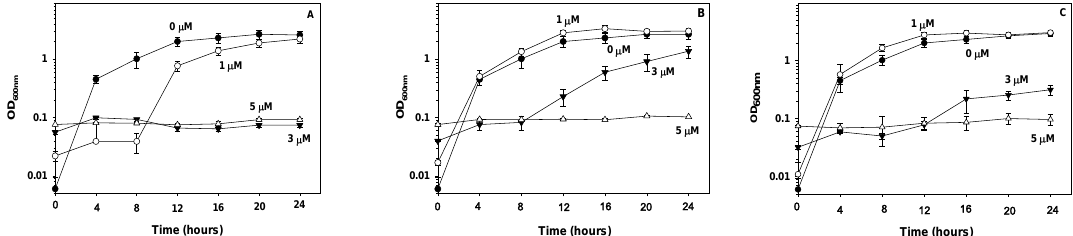
Figure 2. Concentration-dependence of the effect of FePs on E. coli proliferation. Overnight GC4468 LB cultures were diluted 200-fold in M9CA medium. One hundred-microliter aliquots were transferred to a 96-well plate and FePs were added to the specified final concentrations. ( A ) FeTE-2-PyP; ( B ) FeTnHex-2-PyP; ( C ) FeTnOct-2-PyP. Proliferation was monitored by measuring the change of OD at 600 nm using a microplate reader. Results are presented as mean ± SD.